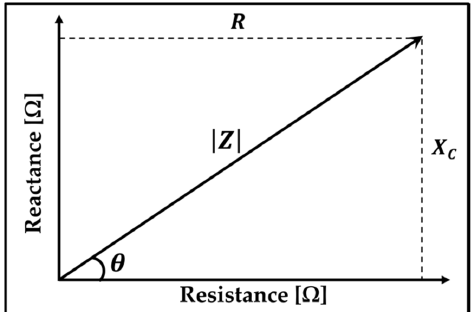
is shown by a vector on the x-axis, and capacitive reactance ( 𝑋 (cid:3004) ) is on the y-axis. A vector from zero to a point that represents both 𝑅 and 𝑋 (cid:3004) on the x-axis and y-axis, respectively, shows the imped- ance amplitude.